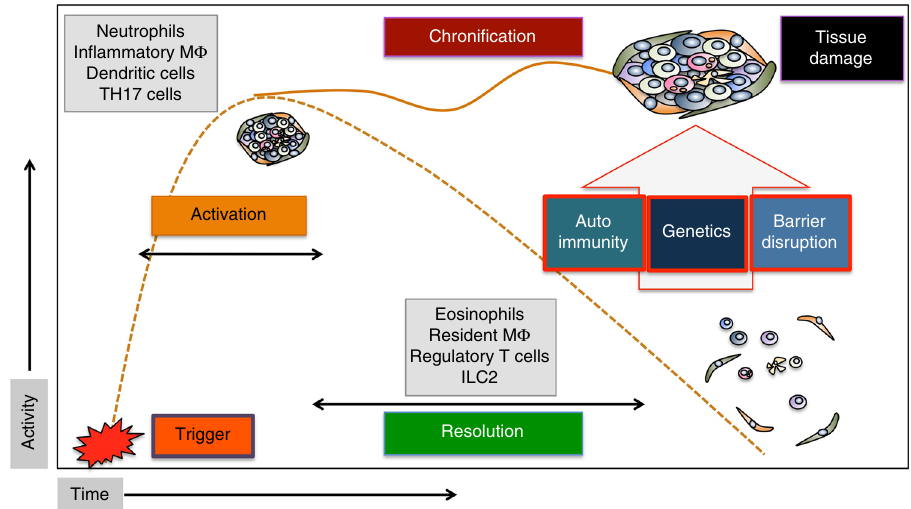
Fig. 1 Activation, resolution, and the process leading to chronicity of in fl ammation. Time course of the in fl ammatory response with activation phase, peak phase, and resolution phase. Failure of resolution leads to chronic in fl ammatory diseases. Key cells of the activation and resolution phase are shown in the gray squares. ILC innate lymphoid cells, TH17 T helper cells 17, M Φ